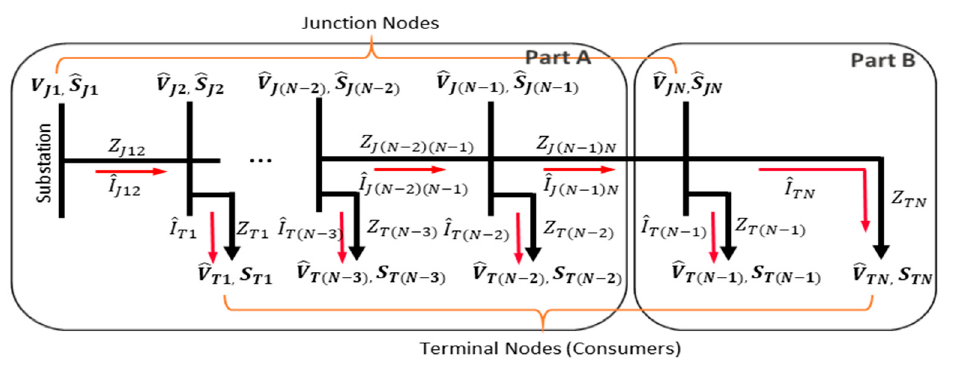
Figure 4. Generalized Linear High-Voltage Distribution network topology